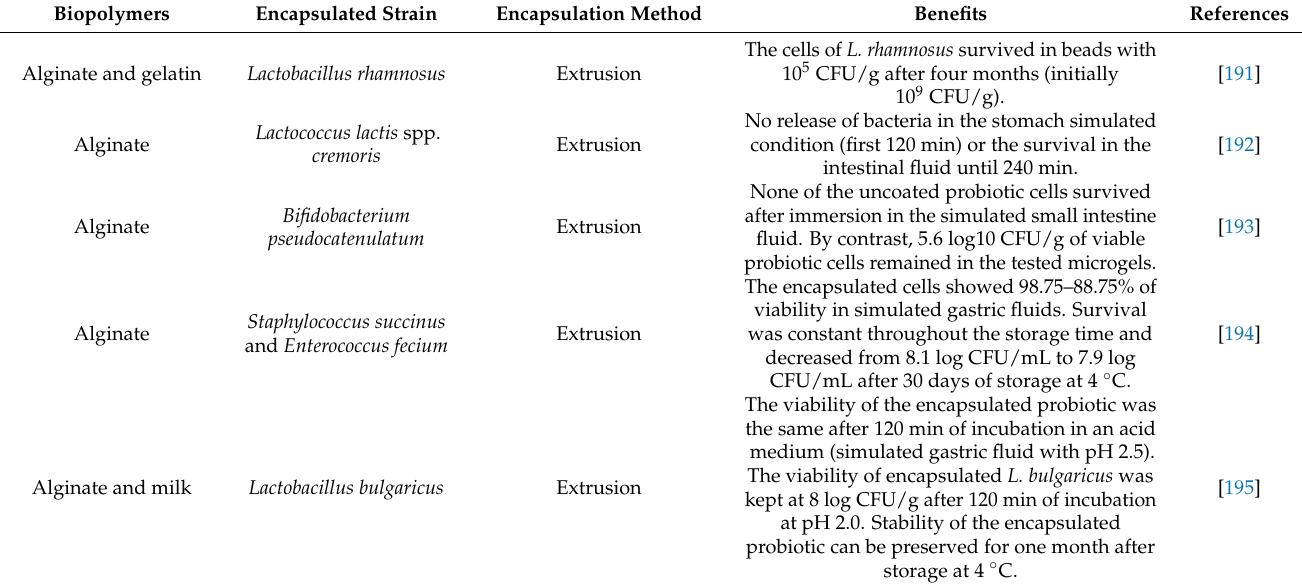
Table 5. Utilization of alginate as a probiotic encapsulating